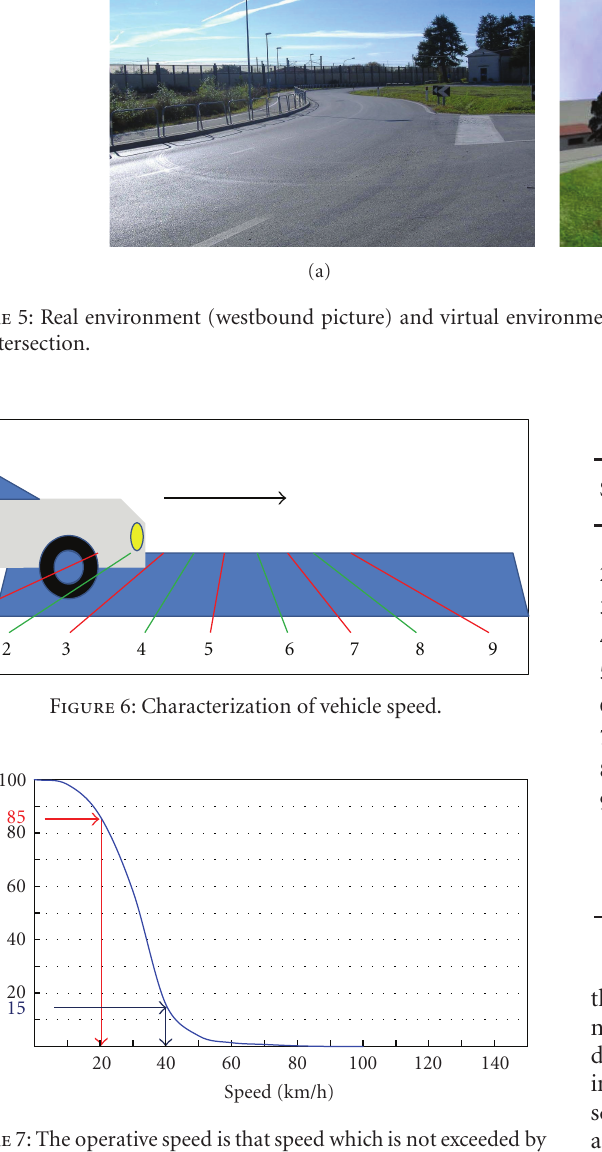
Figure 7: The operative speed is that speed which is not exceeded by the 85% of vehicles. In the diagram, that represents the distribution of velocities in a road section, the 100% of vehicles has a speed higher than 0 km/h; the 15% has a speed higher than 74km/h. The operative speed is 74km/h (it belongs to 100% − 15% of vehicles).